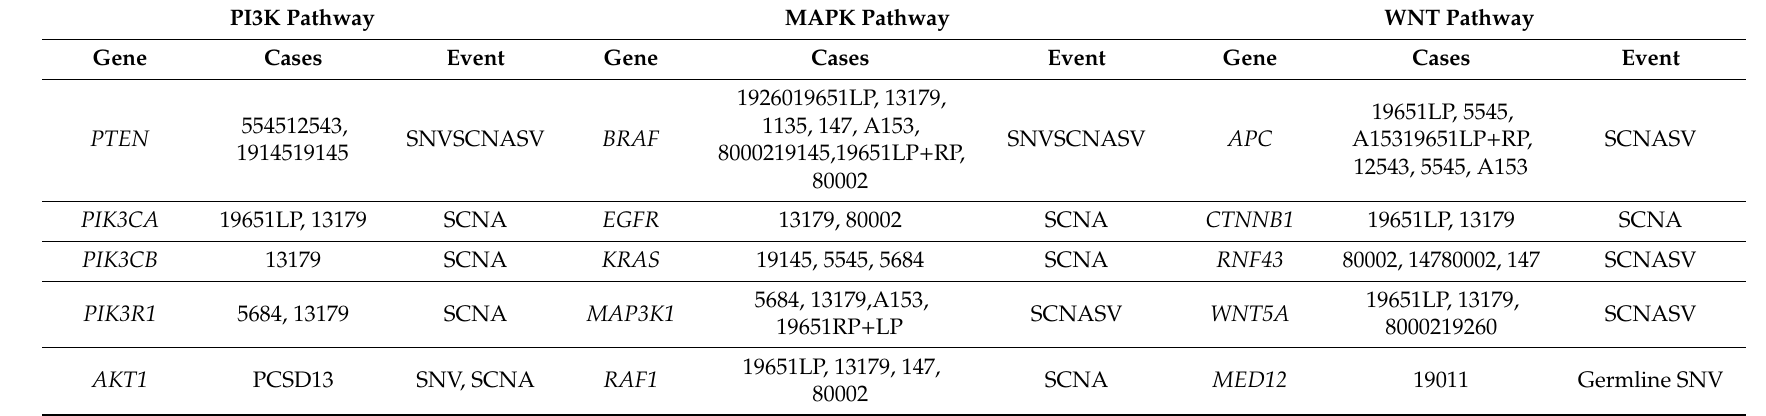
Table 2. Genomic alterations a ff ecting key genes in the PI3K, MAPK and WNT signaling pathways.